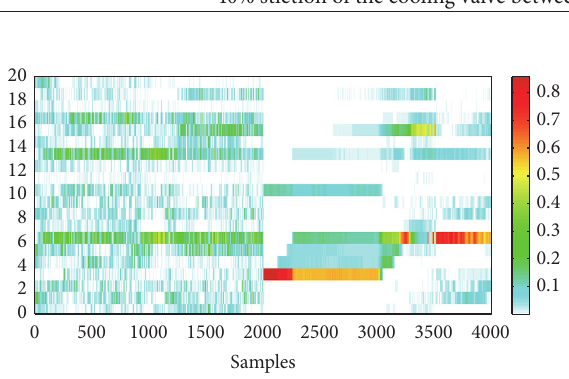
Figure 7: Diagnosis result of fault